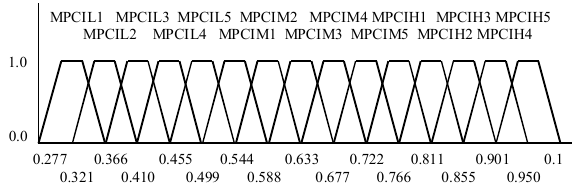
Fig. 7. Membership functions of output MPCIs